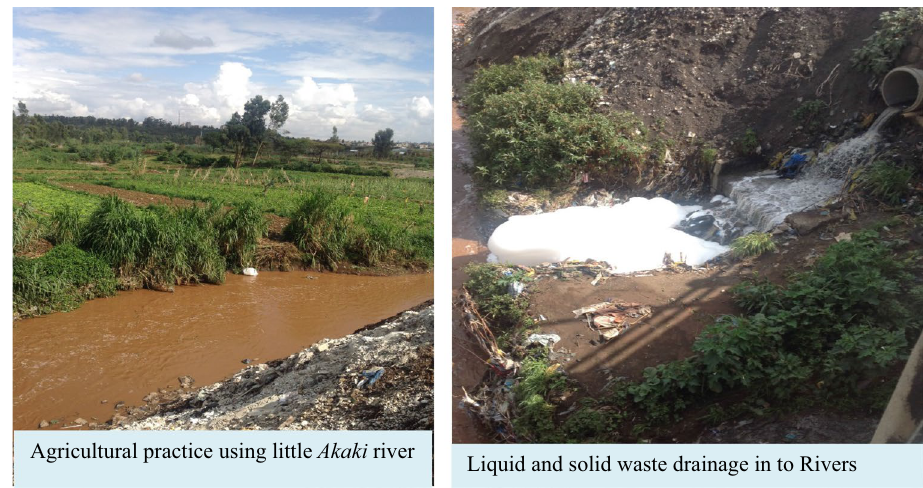
Fig. 3 A picture that demonstrates about how low level of collaboration among various sectors created environmental hazard to the riverside vegetation and agricultural activities. Source Addis Ababa Rivers, Riversides Climate Change Adaptation Project Office, 2018